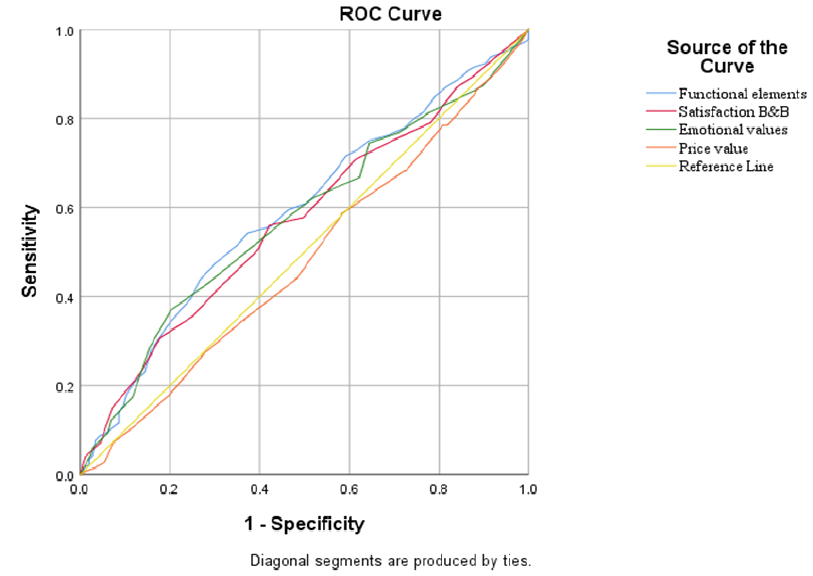
Figure 6. Results of ROC curve analysis.